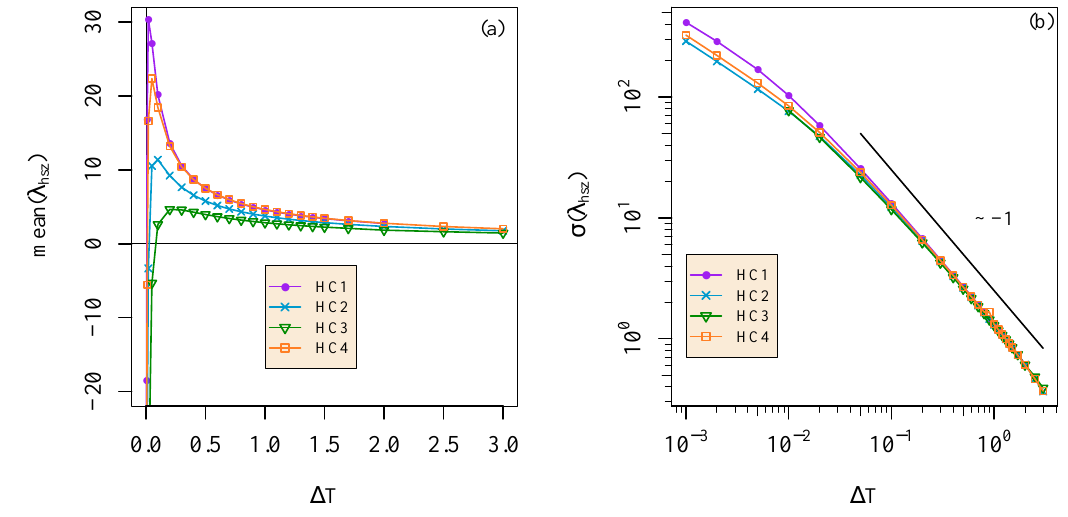
Figure 11. Mean ( a ) and standard deviation ( b ) of λ hsz for simulations HC1, HC2, HC3, and